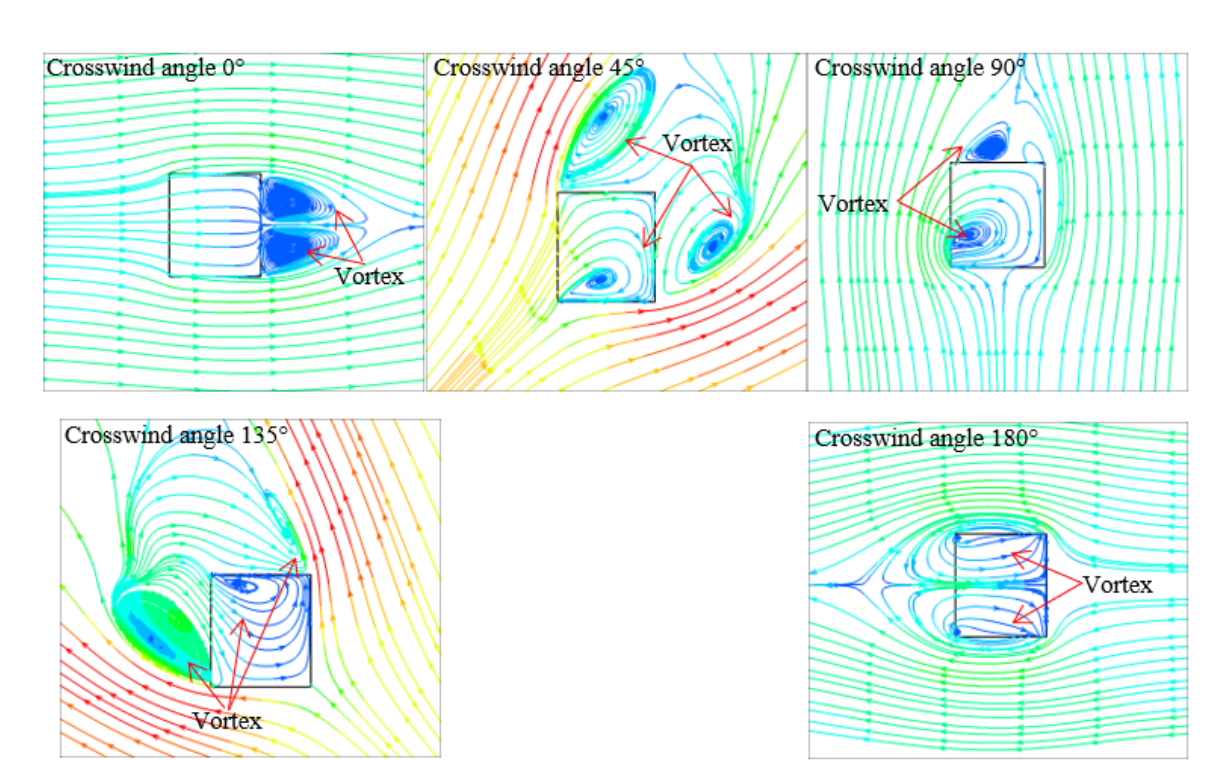
Figure 10. The streamlines around the tower at the plane z=4m.